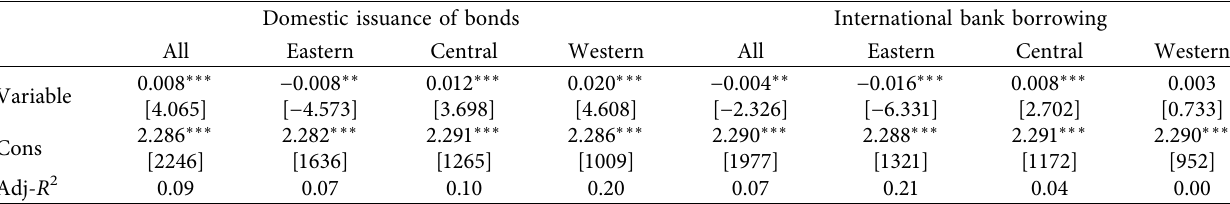
Table 11: Indirect governance efects of borrowing debt.